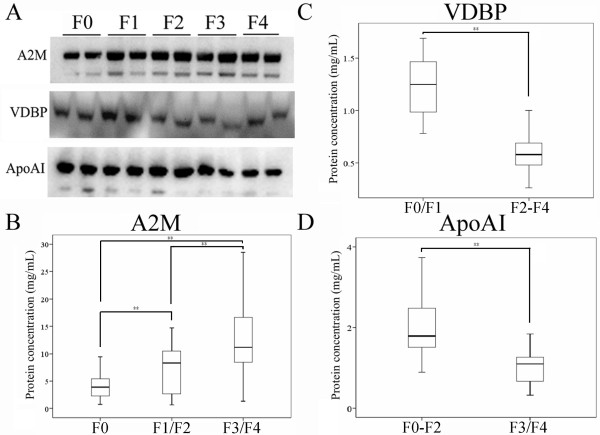
Verification of A2M, VDBP and ApoAI by western blotting (A) and quantification of A2M (B), VDBP (C) and ApoAI (D) by Bio-Plex Suspension Array System. A2M is increased in the F1-F4 stages; VDBP is decreased in the F2-F4 stage and ApoAI is decreased in the F3/F4 stages. **p < 0.01.